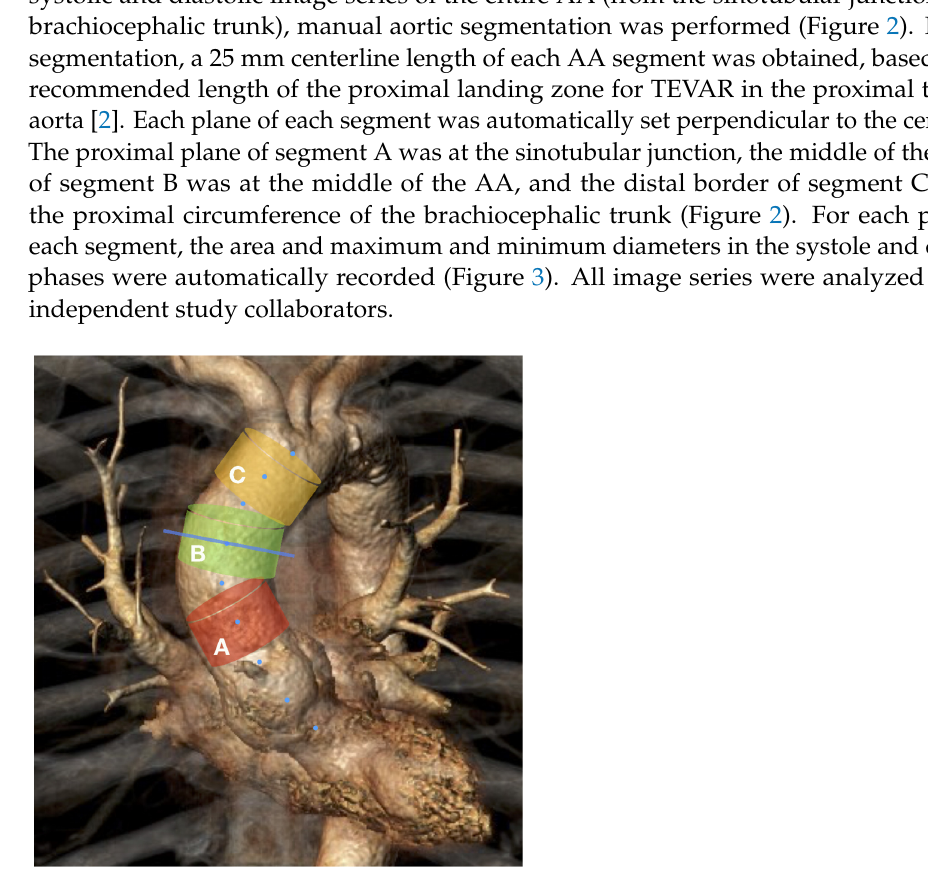
Figure 2. Segmentation of the ascending aorta: Segment A: 2.5 cm distally to the sinotubular junction. Segment B: middle of the segment is on the middle line of the ascending aorta. Segment C: 2.5 cm proximally to the brachiocephalic trunk. All segments had a 25 mm centerline length. Dashed blue line is the centerline. Solid transverse blue line is the middle of the ascending aorta.